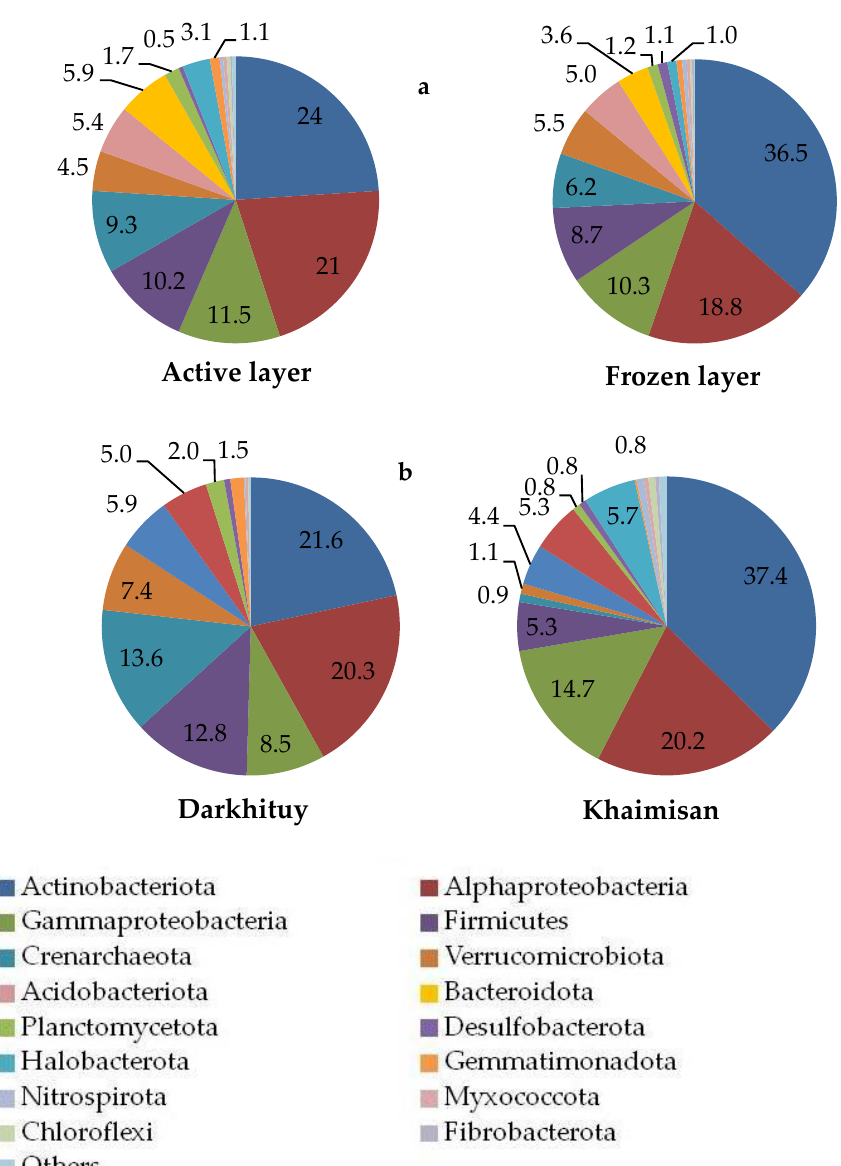
Figure 5. The relative abundance (%) of dominant microbial phyla and proteobacterial classes in the active and frozen layers ( a ); The relative abundance (%) of dominant microbial phyla in the Darkhituy and Khaimisan ecosystems ( b ). All data are presented as the mean. “Others” include phyla with a relative abundance < 1.0.